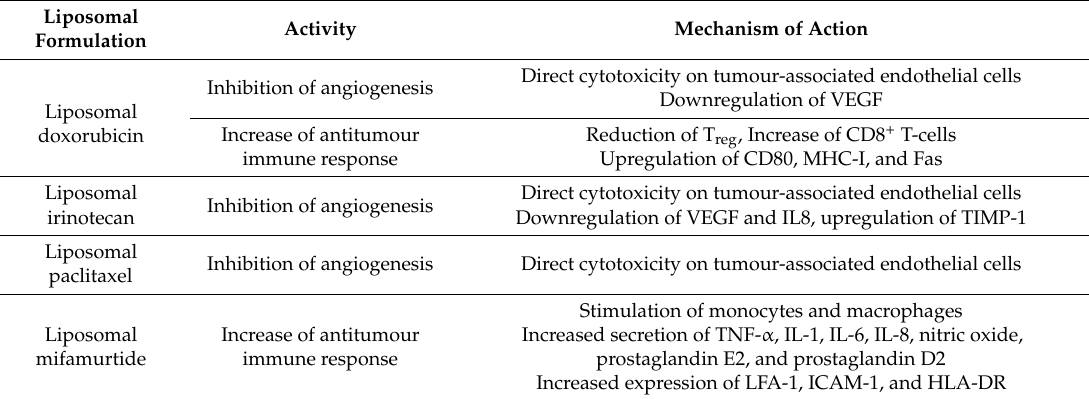
Table 3. Liposomal formulations that modulate the tumour microenvironment (TME) and are used in the